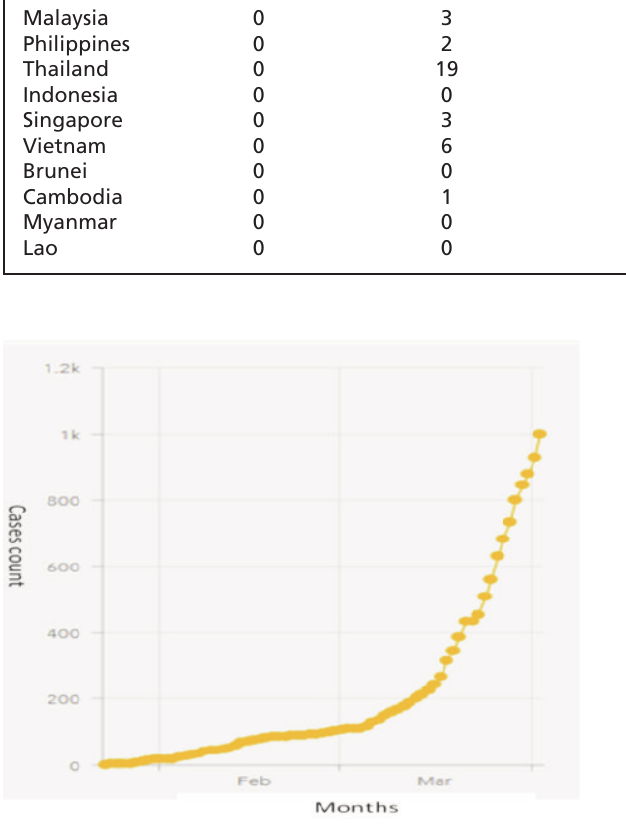
No. of COVID-19 cases in Malaysia by date 10 . Fig. 2: